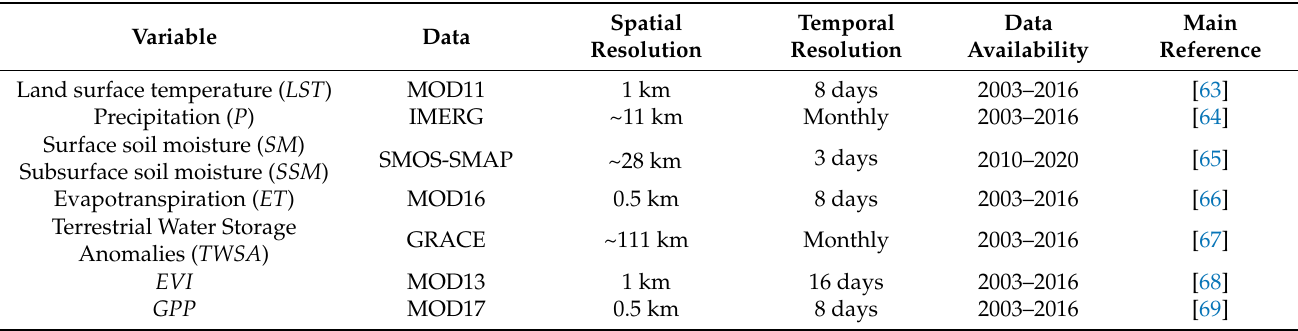
Table 1. Synthesis of remote sensing